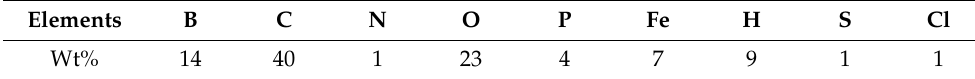
Table 2. Elements content of composite